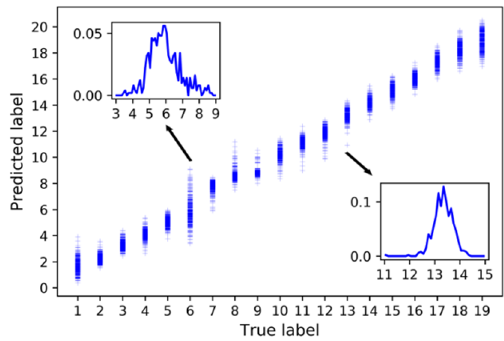
Figure 11. Prediction results BPNN model.